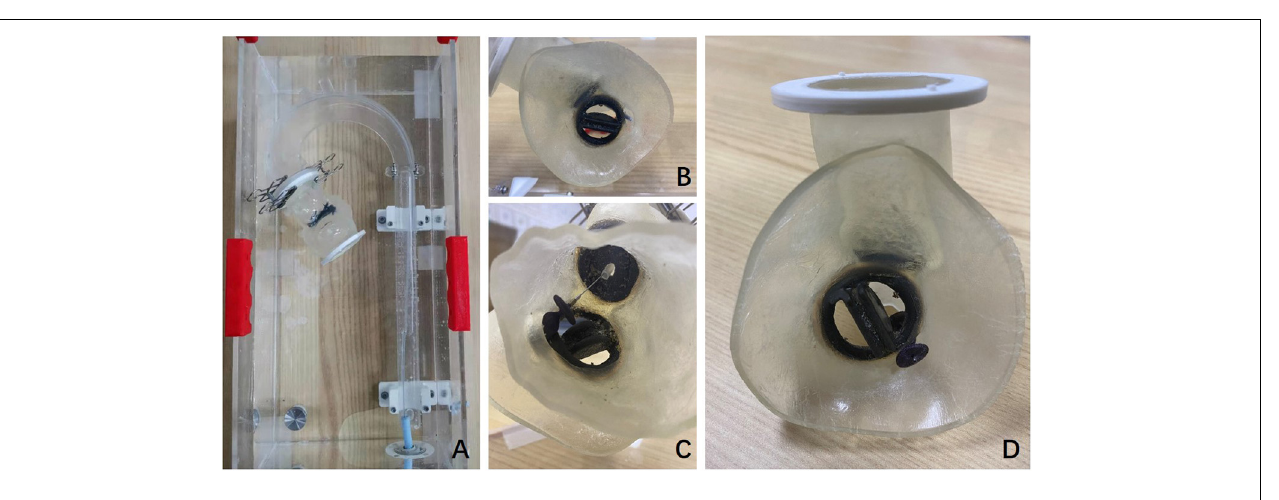
FIGURE 3 | Preoperative 3D printing model and preoperative simulation in vitro . (A) The preoperative plan was simulated in an external phantom using the 3D printing model. (B) The mitral PVL and its position as seen in the 3D printing model. (C) The implantation of the occluder in the mitral PVL was performed retrogradely via the femoral artery in the 3D printing model. (D) The 3D model shows the situation after the occluder was implanted in the mitral